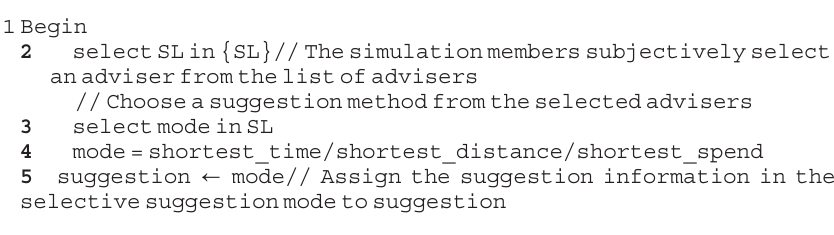
Algorithm 3. Decider_ vehicle(con fi denceLevel, ID, in fl uence, learnability,